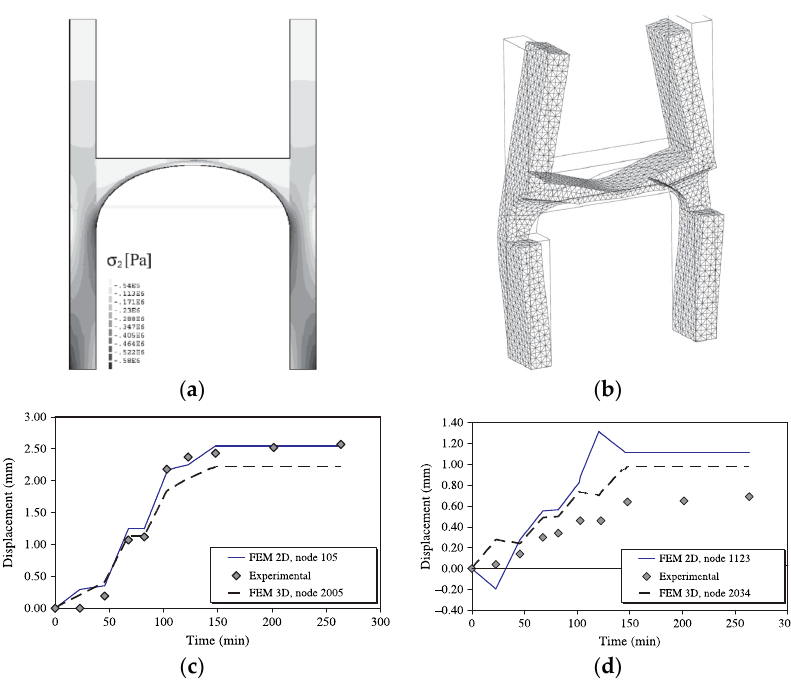
Figure 7. Hospital San Giovanni: photograph inside the vault.